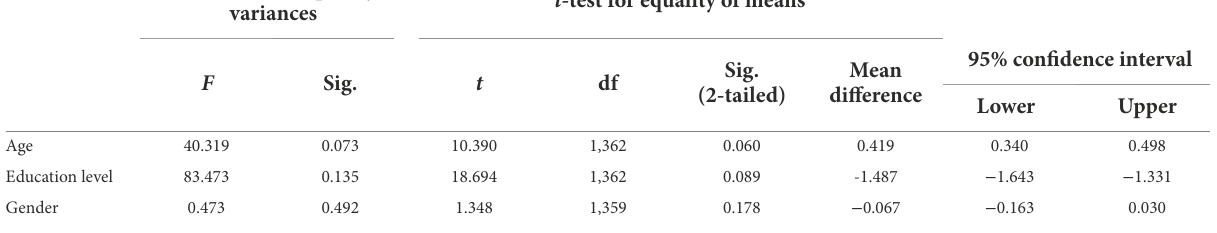
TABLE 1 Demographic differences between teachers and parents. Levene’s test for equality of